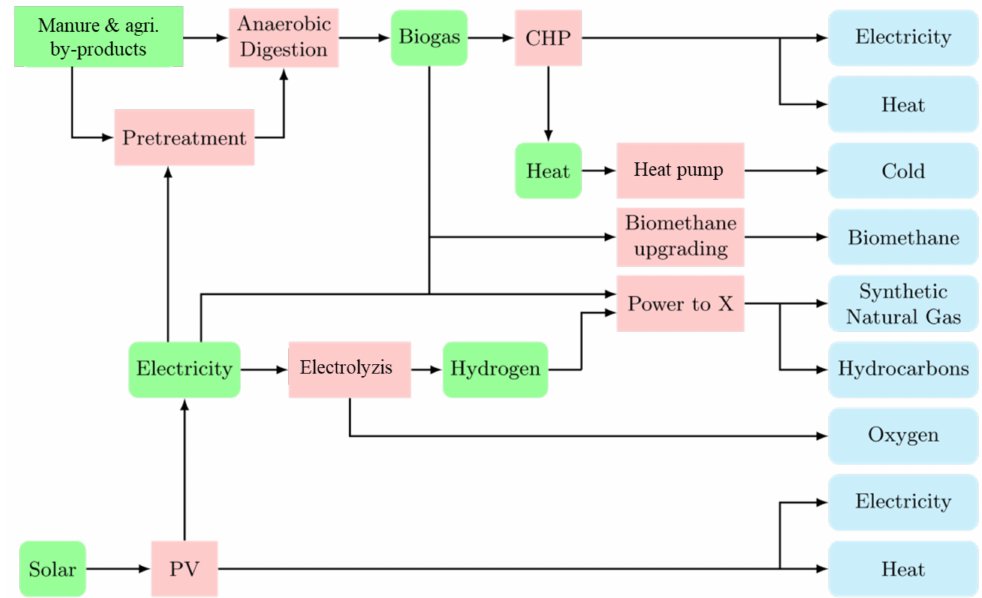
Figure 2. Overview of the various technologies identified as possible complementarities between solar and biomass resources and the possible links between the conversion paths. Conversion processes are shown in red, intermediate energy carriers in green and final energy carriers in